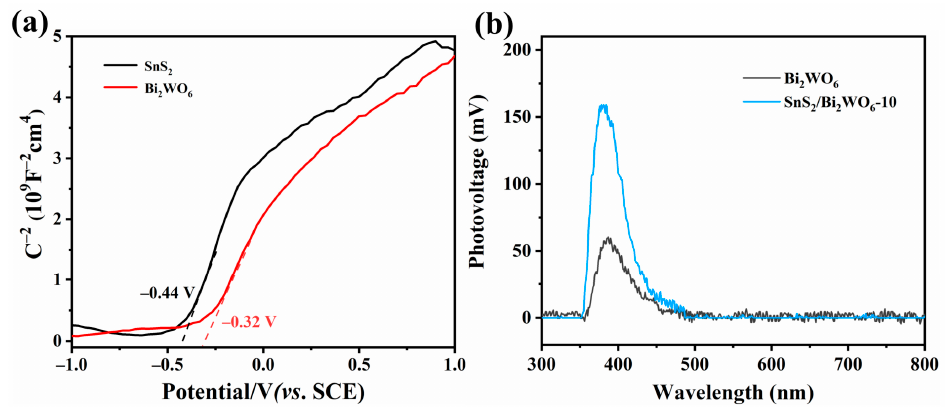
Figure 7. Mott–Schottky plot of ( a ) Bi 2 WO 6 and SnS 2 , ( b ) surface photovoltage spectra. Based on the above experimental results and discussion, the possible reaction mech- anism is as follows: electrons (e − ) in the valence bands (VBs) of SnS 2 and Bi 2 WO 6 are excited and transfer to the CBs under sunlight irradiation, thus leaving the same number of holes (h + ) in the VBs of SnS 2 and Bi 2 WO 6 . Then, the photogenerated electrons on the CB of Bi 2 WO 6 are transferred to the VB of SnS 2 , subsequently the electrons are excited to the CB of SnS 2 . Therefore, the photogenerated electrons and holes of the SnS 2 /Bi 2 WO 6 photocatalyst are effectively separated by constructing Z-scheme heterojunction. Based on Equations (1)–(3) [28], the electrons on the CB of SnS 2 have enough reduction ability to re- duce the CO 2 to methanol and ethanol. This is further demonstrated by Pt photodeposition experiment on SnS 2 /Bi 2 WO 6 -10 (Figure S9). In addition, the Bi 2 WO 6 sphere is composed of intricate nanosheets, so some intermediates ( · CH 3 , · OCH 3 ) may not be converted into methanol immediately, and the dimerization reaction takes place, and finally ethanol can be formed (Figure